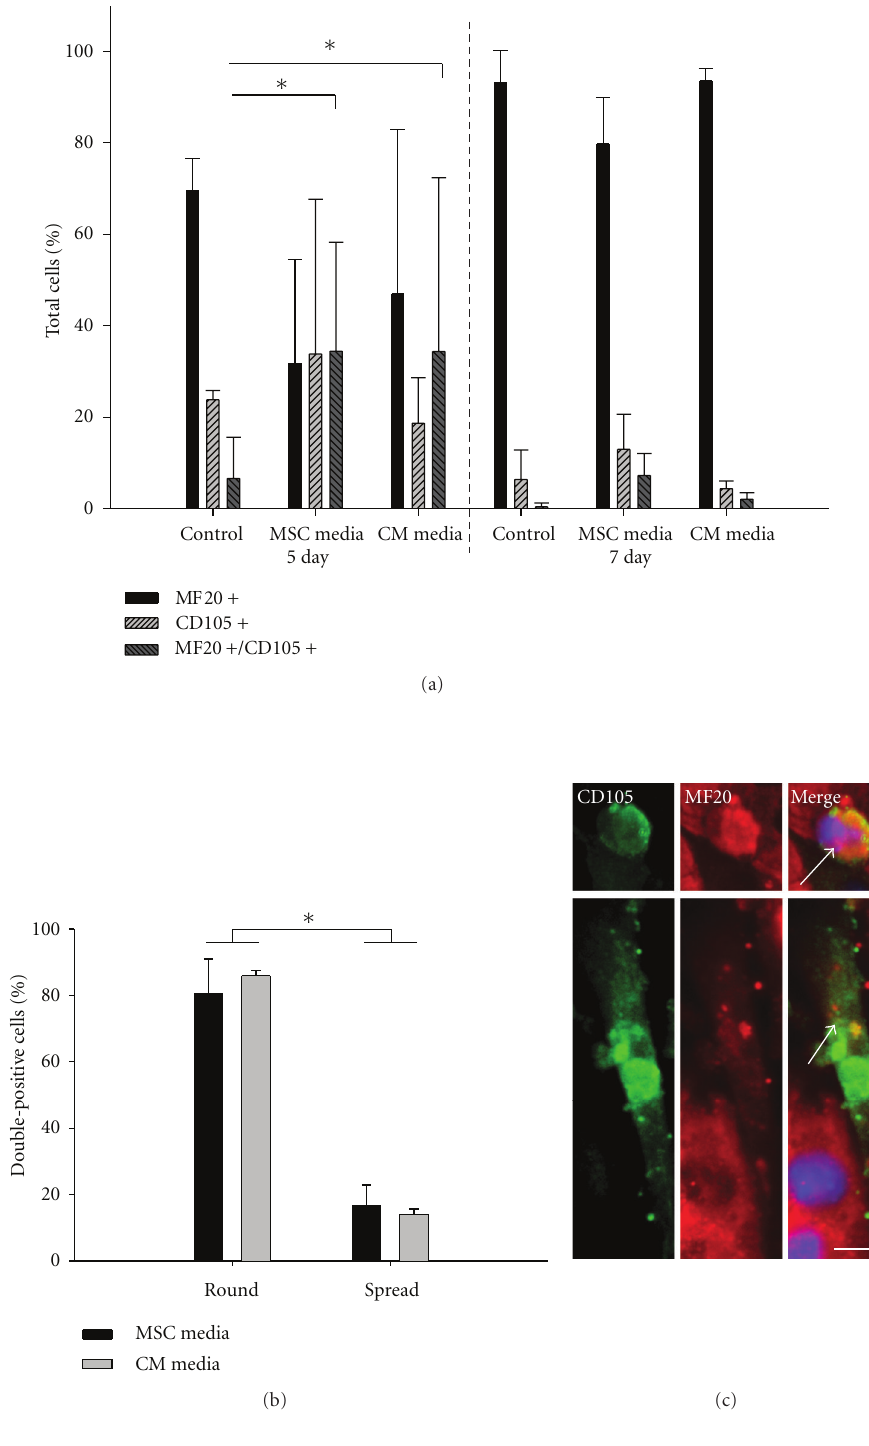
Figure 3: Phenotypic and morphologic characteristics of vMSC-CM fusion products. After pH-induced fusion, fusion products display two distinct morphologies: CM-like (round) and MSC-like (spread). Fusion products were probed for markers indicative of MSC (CD105) and CM (MF20) phenotype. (a) MF20 + /CD105 + cells are significantly increased with vMSCs at day 5 relative to untransfected MSCs, while the culture environment (MSC medium and CM medium) had no e ff ect on the percent of dual positive events in vMSC-CM cocultures at day 5. ∗ P < 0 . 05. (b) Morphology of MF20 + /CD105 + cells was typically CM-like and culture environment did not alter this tendency. ∗ P < 0 . 05. (c) Representative morphologies of MF20 + /CD105 + cells. White arrows indicate MF20 + /CD105 + cells. Scale bar = 25 μ